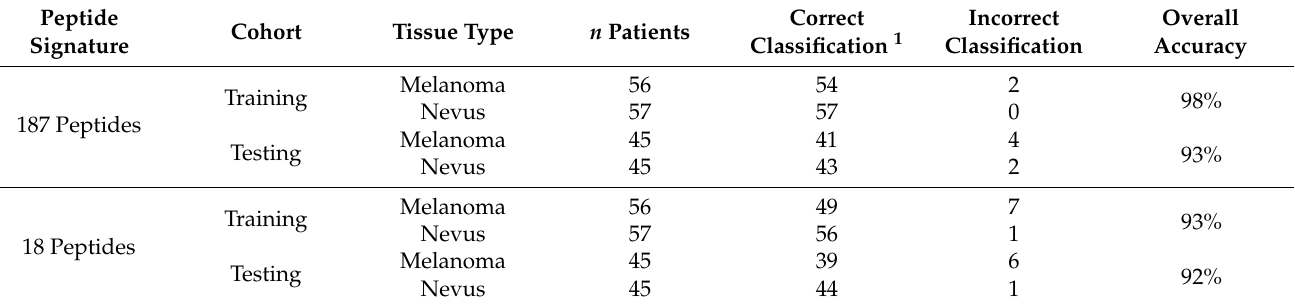
Table 1. Classification results of melanoma and nevi samples through MALDI MSI-based proteomic analysis.